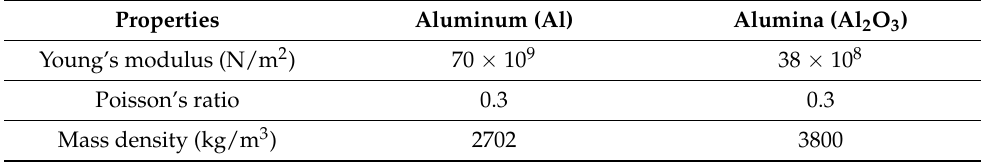
Table 1. Material properties for an FG